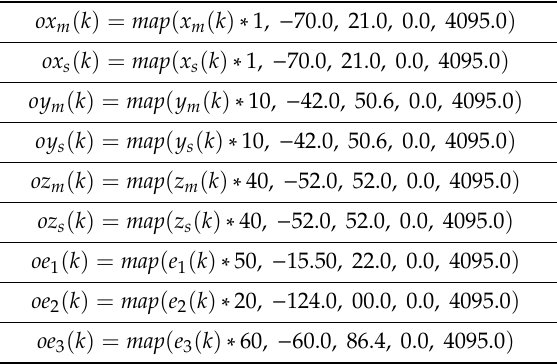
Table 1. Scaling values of the experimental test using map